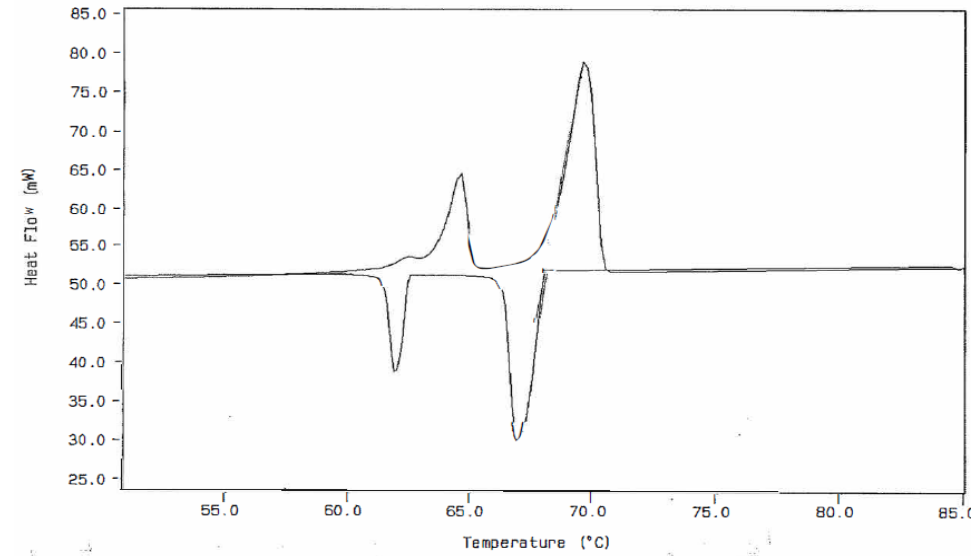
Figure 4. DSC Thermal Curve for a 3.050 Milligram Sample of n ‐ Dotriacontane at a Heating Rate of 5.0 °C/min (Upper) Followed by a Dynamic Cooling Rate of 3.0 °C/min (Lower).